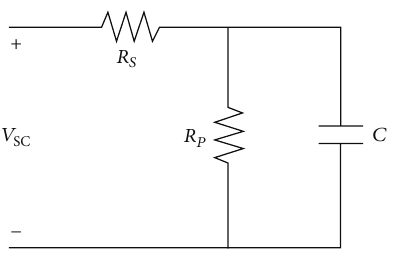
Figure 6: Classical equivalent model for SC.